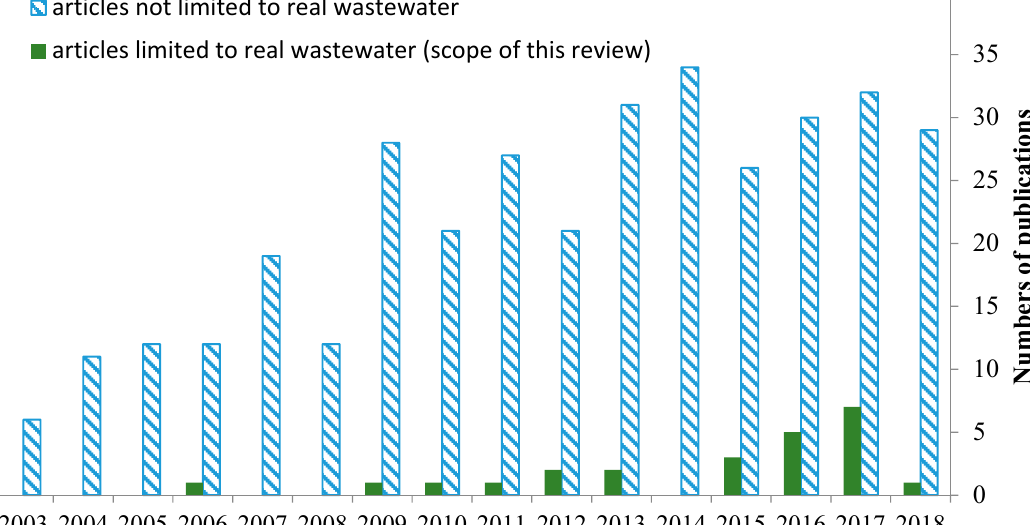
Figure 1. Number of scientific publications per year containing keywords (Scopus): “Fenton”, “wastewater” and “toxicity” in the title and/or keywords of article (blue). Number of articles in which real wastewater matrix was used (green).